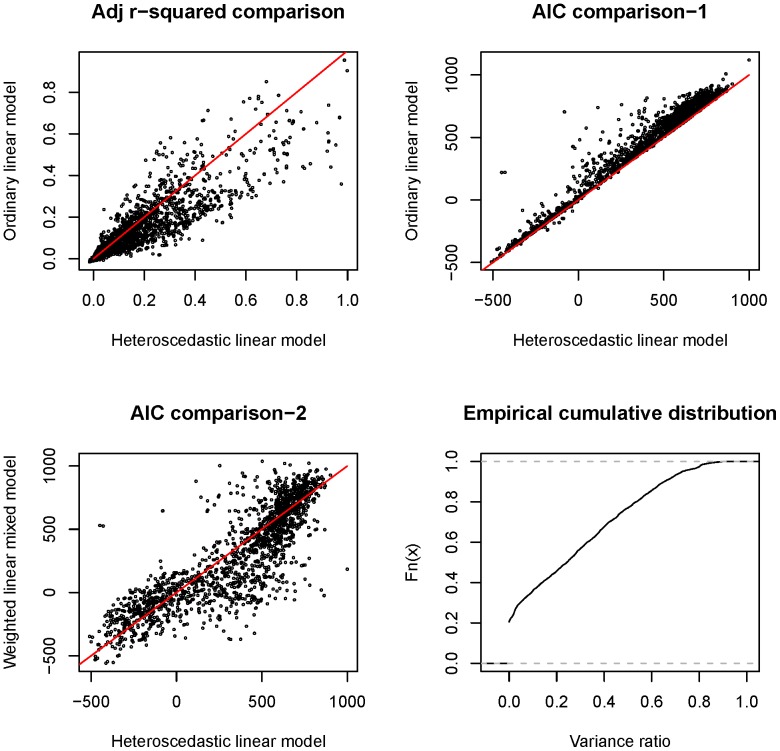
Model comparison and variance ratio distribution.In the scatter charts (plots A, B and C), each point represents a gene::SNP pair with the two Adj R-square (or AIC) values obtained by implementing the corresponding statistical models as specified by the x- and y- axis labels. In plot D, the variance ratio represents the proportion of the total variance accounted by the random effect component (SUBJECT) as estimated by the weighted linear mixed model.